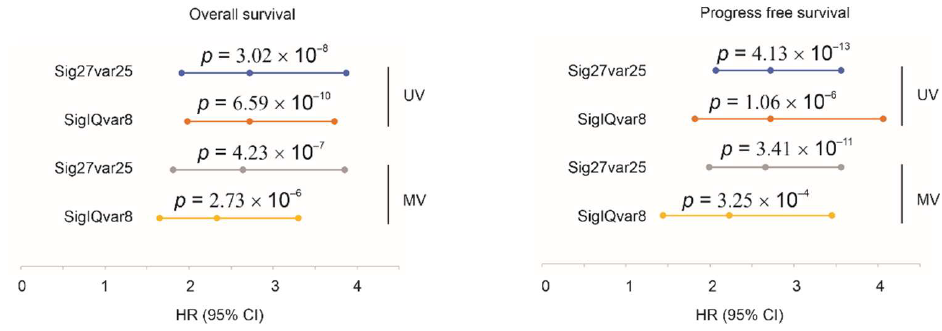
Figure 3. Clinical factor independent prediction of ACC progression and poor prognosis by Sig27var25 and SigIQvar8. UV: univariate Cox analysis; MV: multivariate Cox analysis. MV in- cluded age at diagnosis and stages with stages I and II were grouped into “0” and stages III and IV were classified as “1”. Table 1. Univariate and multivariate Cox analyses of Sig27var25 component genes in predicting ACC poor OS and progression.